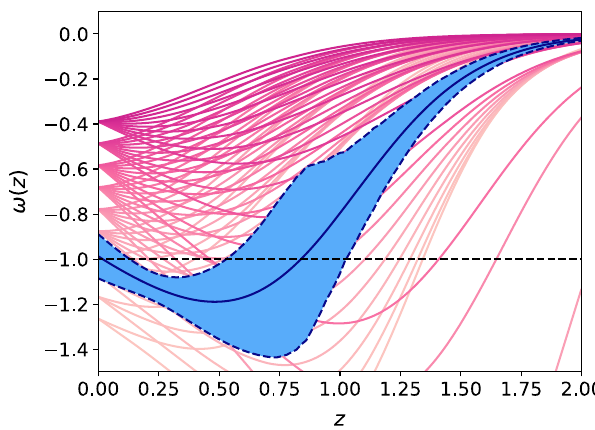
effective EoS (cyan) and its derivative with respect to z (magenta). The regions delimited by dashed lines show the 1 σ confidence limits esti- mated from a MCMC analysis